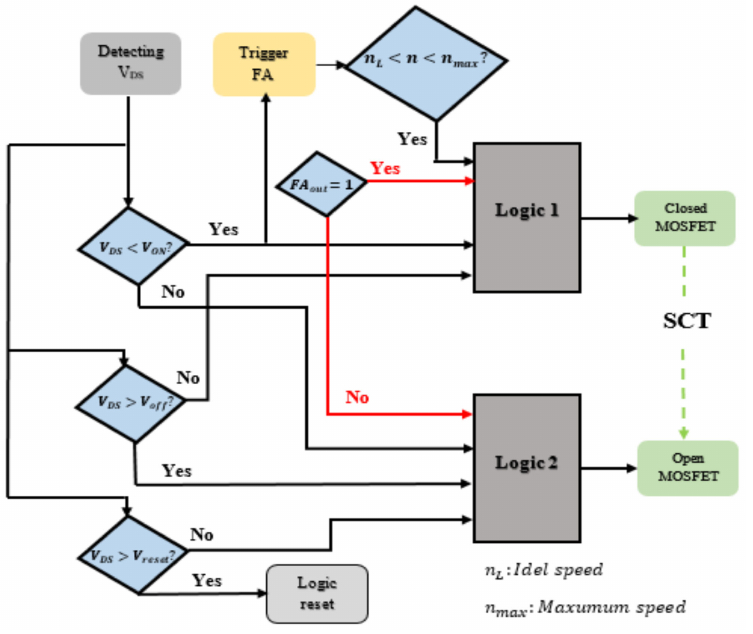
Figure 43. Flowchart for the D-FT algorithm “Reprinted from